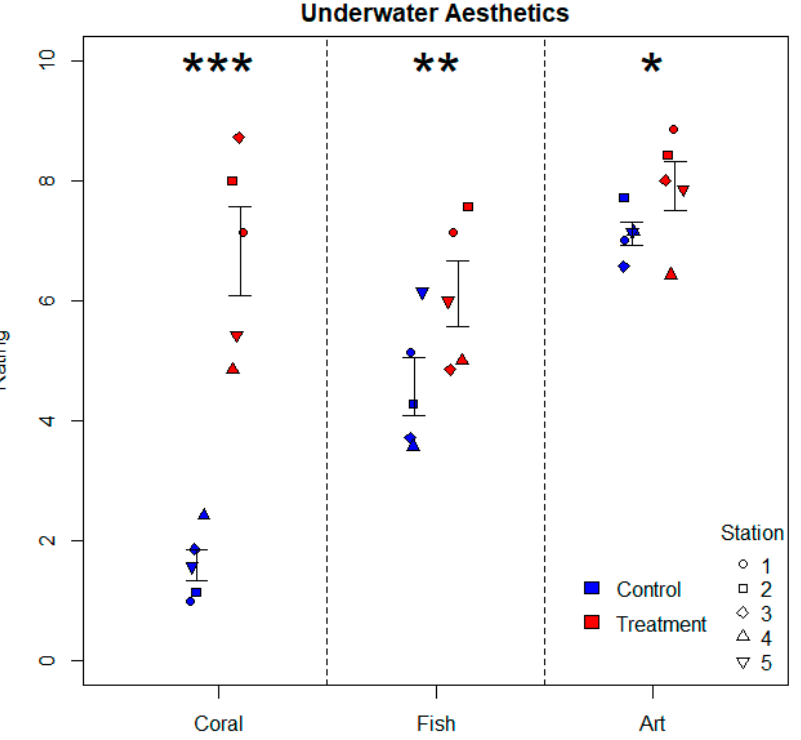
Figure 10. Average aesthetic rating in control versus treatment for each category ( n = 7). Error bars represent the standard error. Asterisks represent statistical differences between control and treatment groups of each category, as determined by a t -test (*: p -value = < 0.05, **: p -value = < 0.01, ***: p -value = < 0.001). Table 7. Analysis of underwater aesthetic scores for corals, fish and art using ANOVA.